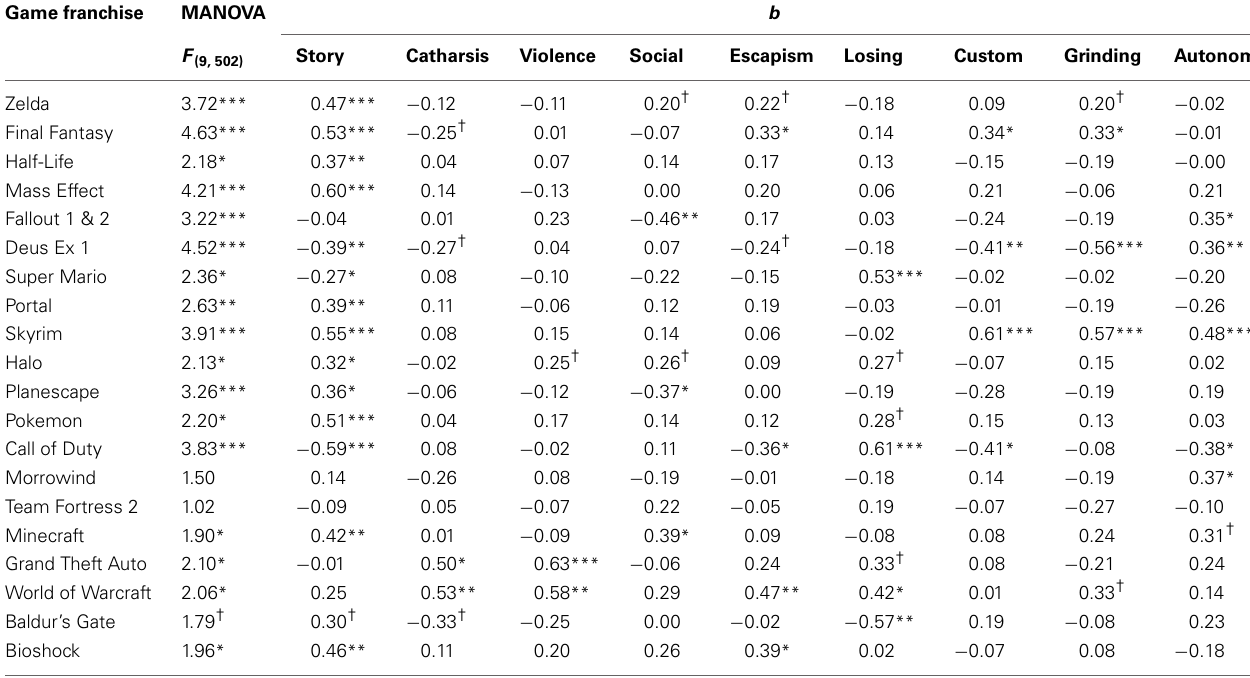
Table 5 | Coefficients of favorite game franchises on GAMES factor scores.